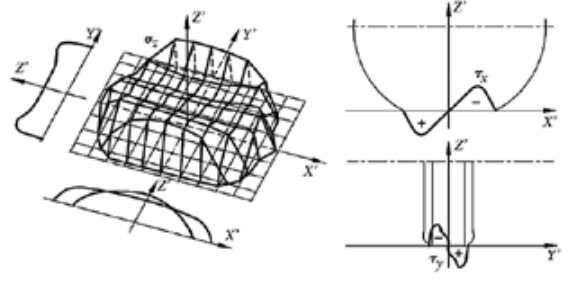
Fig. 2. Distribution of pressure components in the tyre-road contact zone